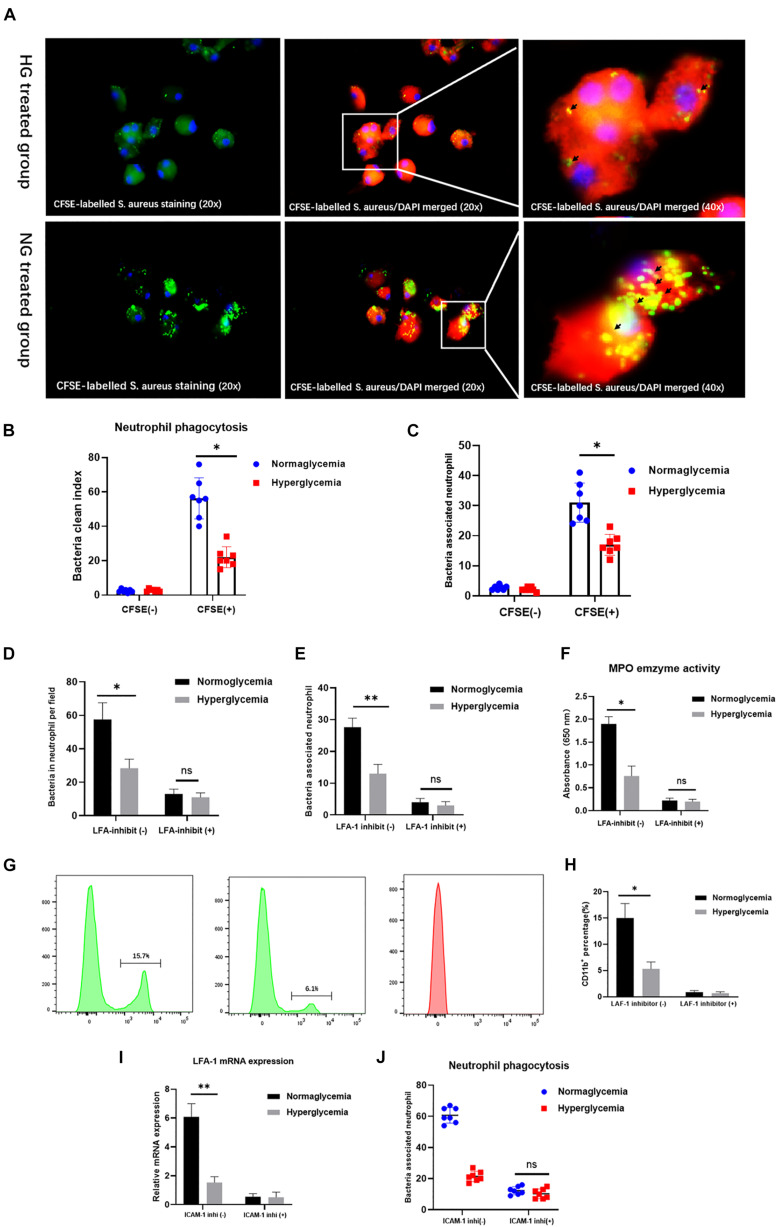
ICAM-1 and LFA-1 regulate neutrophil phagocytosis in HG culture. (A,B) The neutrophil clearance index was reduced in the HG group. The CFSE-labeled S. aureus staining (20x) were presented in the left side. The CFSE-labeled S. aureus/DAPI merged images (20x) were presented in the middle. Images in upper side were from hyperglycemia treated group. Images in lower side were from normoglycemia treated group. Short black arrows indicate labeled bacteria cleared by neutrophils. (C) The total number of positive phagocytic neutrophils associated with labeled bacteria was decreased in the HG group. (D,E) The number of positive phagocytic neutrophils was significantly reduced in the NG group following exposure to the LFA-1 inhibitor. (F) Myeloperoxidase (MPO) enzyme activity was reduced 1.2-fold in the HG group, and further decreased by exposure to the LFA-1 inhibitor. (G,H) CD11b expression was elevated in the NG group. However, neutrophils in the absence of LFA-1 exhibited low CD11b levels in both the NG and HG groups. (I) LFA-1 expression levels were decreased in both the HG and NG groups following exposure to the ICAM-1 inhibitor. (J) Neutrophil phagocytosis was attenuated after administration of the ICAM-1 inhibitor. Bars represent mean ± SD. *P < 0.05; **P < 0.01.